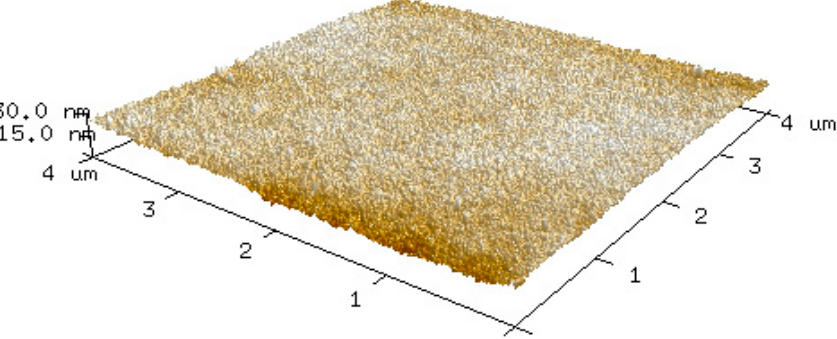
Figure 8. The 3D atomic force microscopy (AFM) images of an uncoated membrane (top) and a three-day coated membrane (bottom).